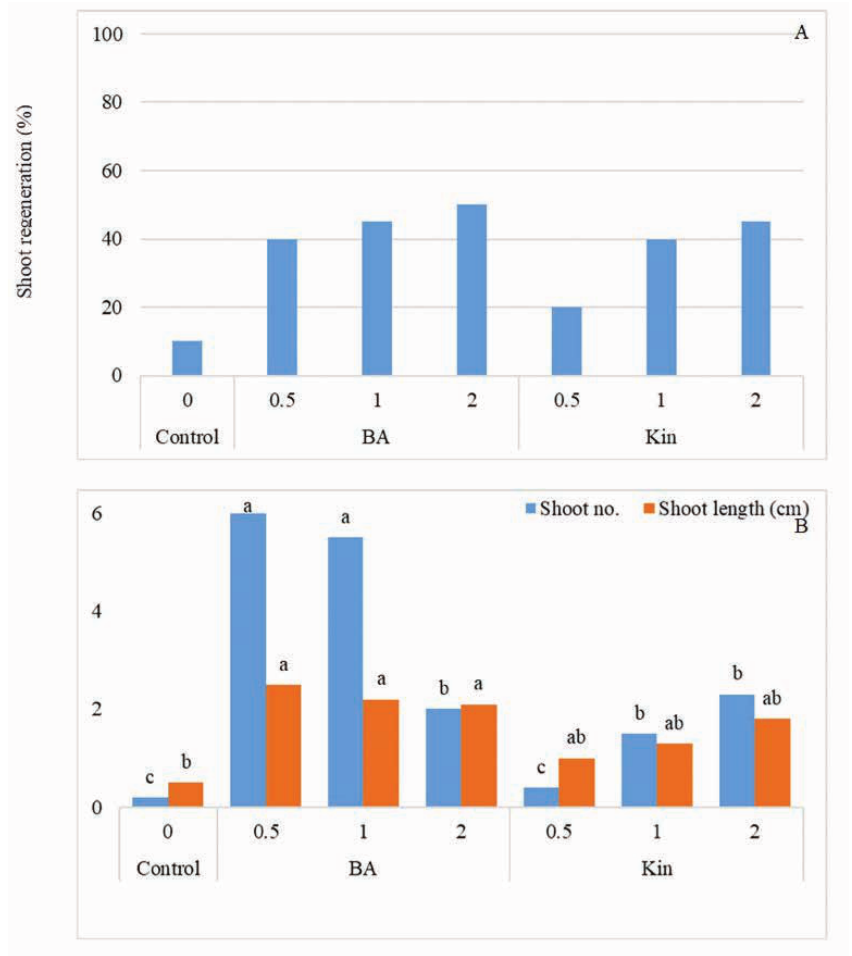
Figure 3: Effect of BA and Kin on the percentage of shoot regeneration (A) and the mean number of shoots/callus and shoot length of ginger (B). Means with shared letter(s) in each column for each factor showing insignificant differences (LSD, α≤